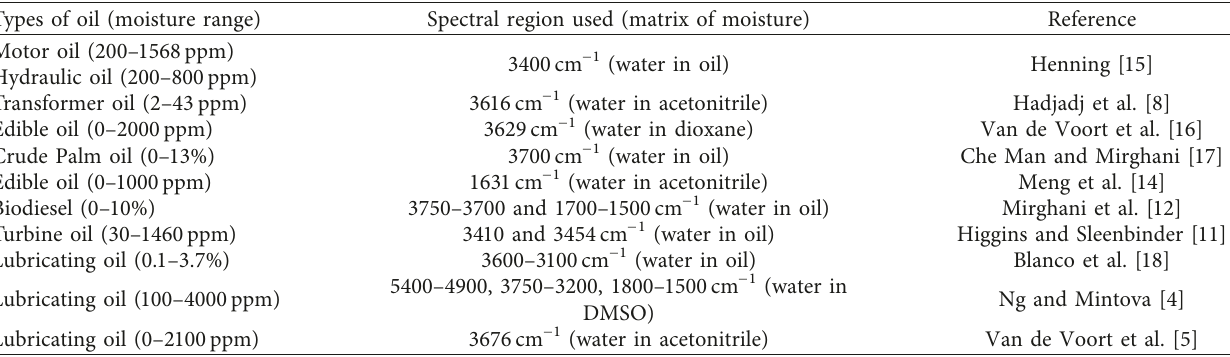
Figure 3: Predicted versus expected concentrations of training/test sets for lubricating oil. (a) % RMSE (c) % RMSE 14.15, and (d) % RMSE (cid:26) (cid:26) Table 1: Summary of literature studies of moisture in oil using FTIR.